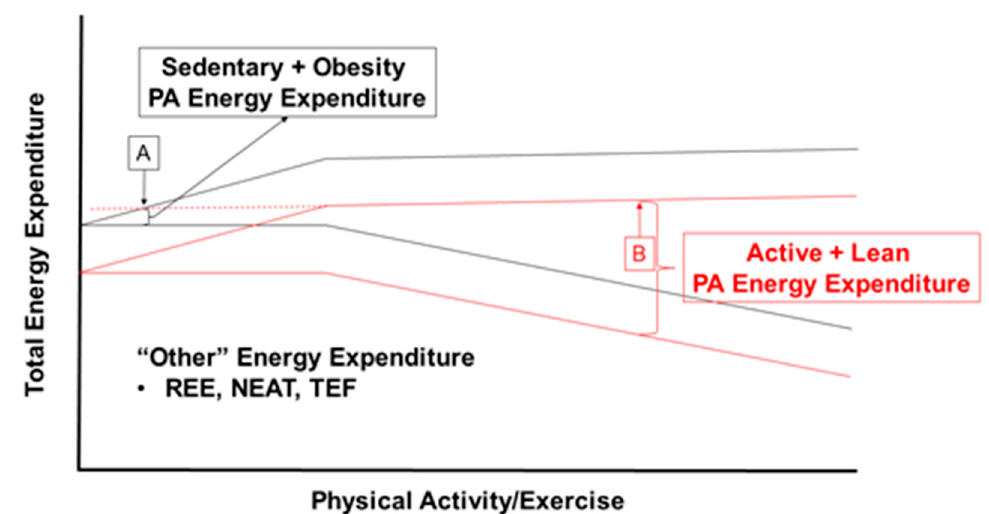
Figure 3. Theoretical scenarios where total daily energy expenditure and energy flux are constant between points A and B, but the contribution of physical activity energy expenditure is substantially different. Black and red lines represent regression lines for the Constrained Total Daily Energy Expenditure Model with no adjustment for body size. At point A, a high energy flux state is achieved through a sedentary lifestyle and large body size. At point B, high flux is achieved at a lower body weight and highly active lifestyle. Abbreviations: PA, physical activity; REE, resting energy expenditure; NEAT, non-exercise activity thermogenesis; TEF, thermic effect of feeding.